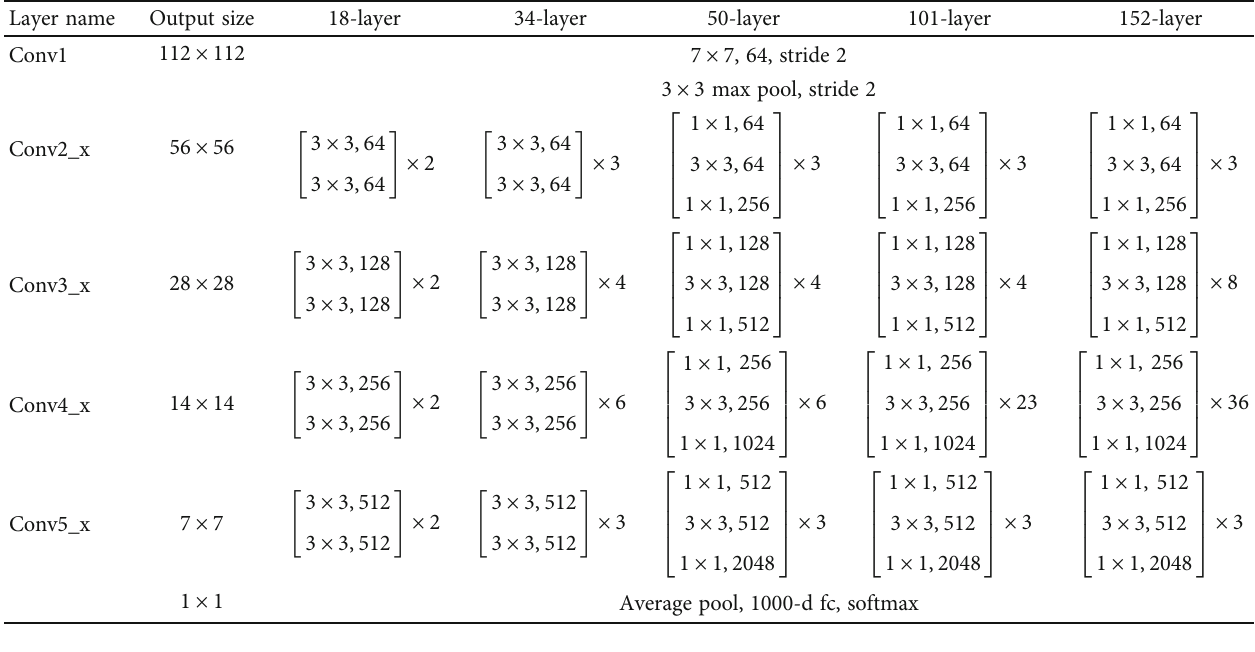
Table 6: Network structures of ResNet.